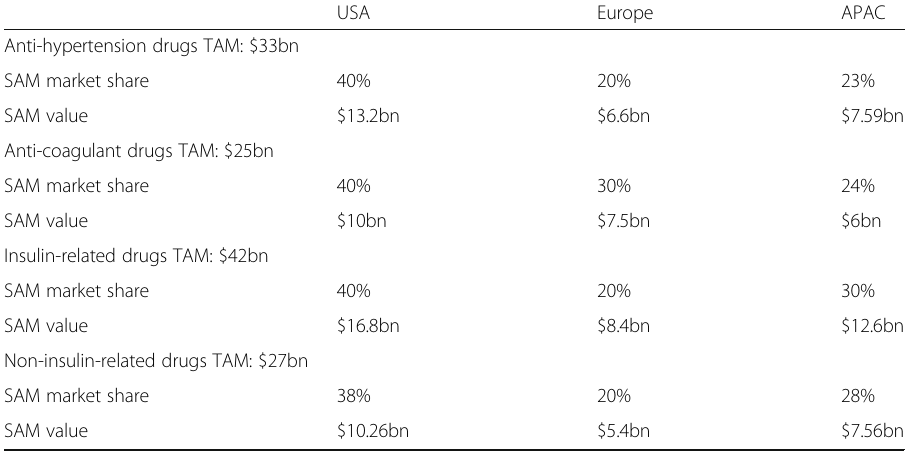
Table 1 TAM, and SAM for hypertension, blood thinning, insulin-related and non-insulin-related drugs. Figures presented are annual values USA Europe